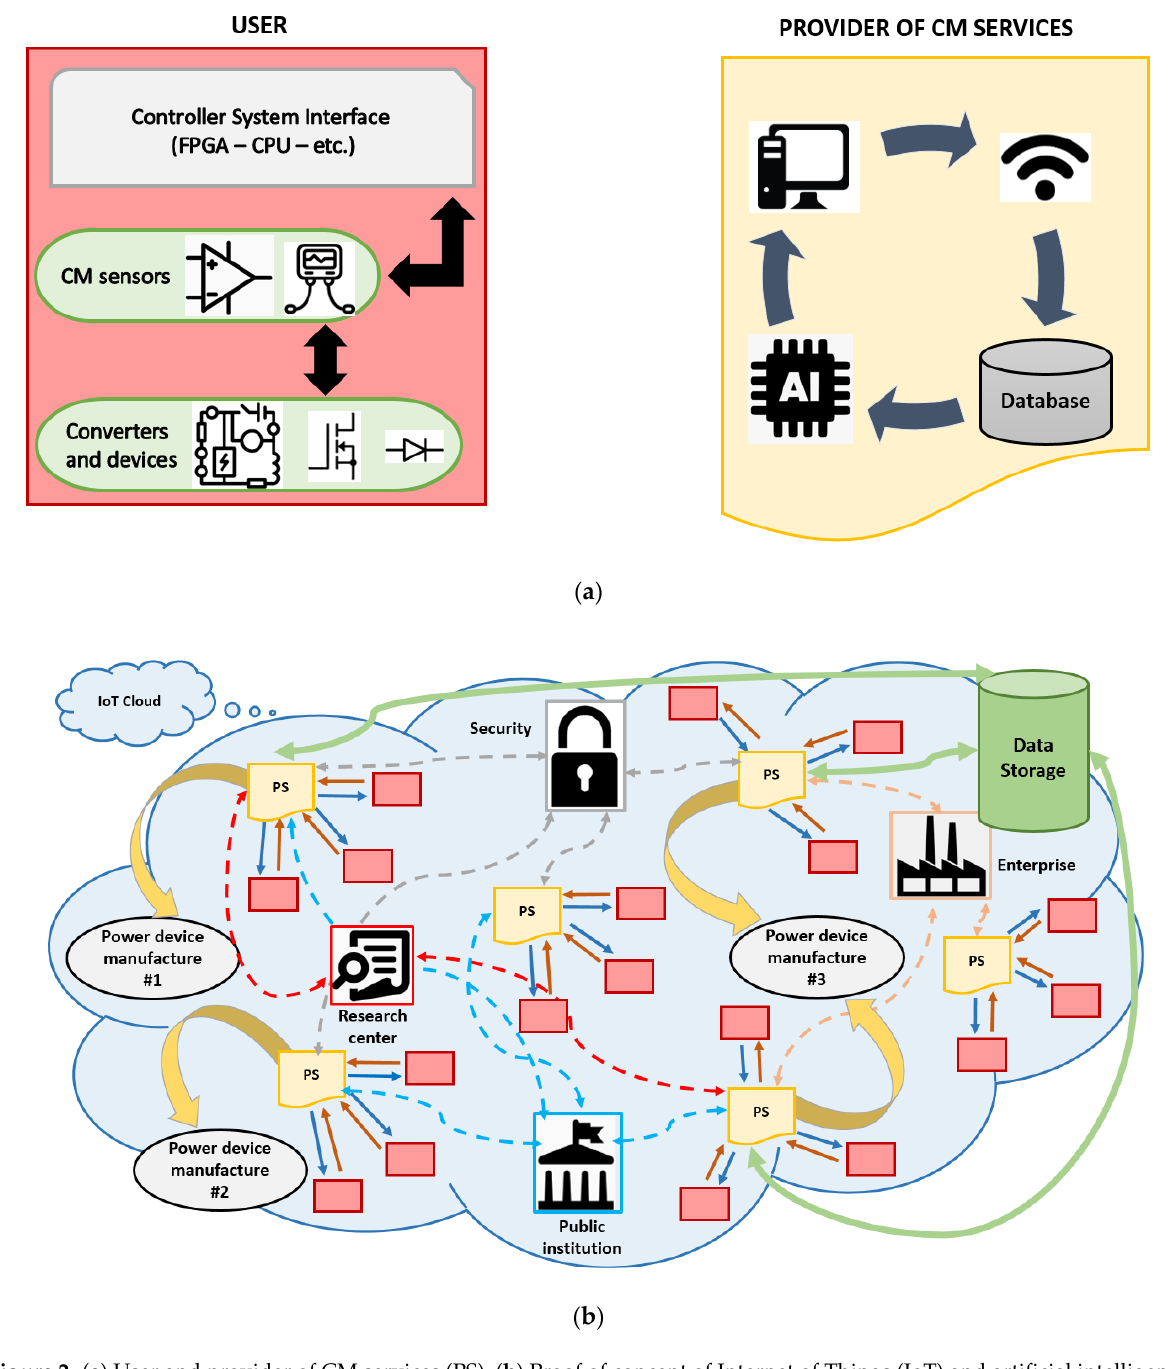
Figure 2. ( a ) User and provider of CM services (PS). ( b ) Proof of concept of Internet of Things (IoT) and artificial intelligence (AI) technologies for CM of power devices.